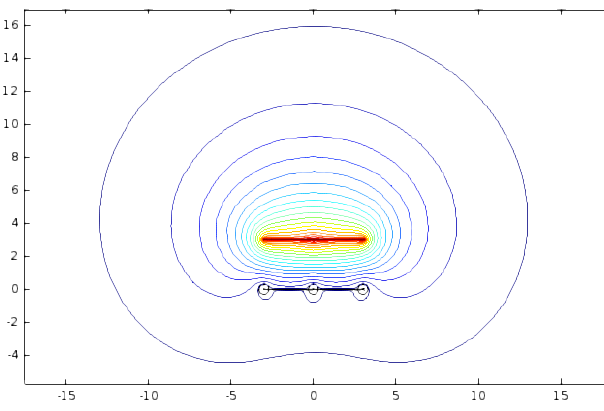
Fig. 12. Simulation of equipotential lines in plane parallel to surface of